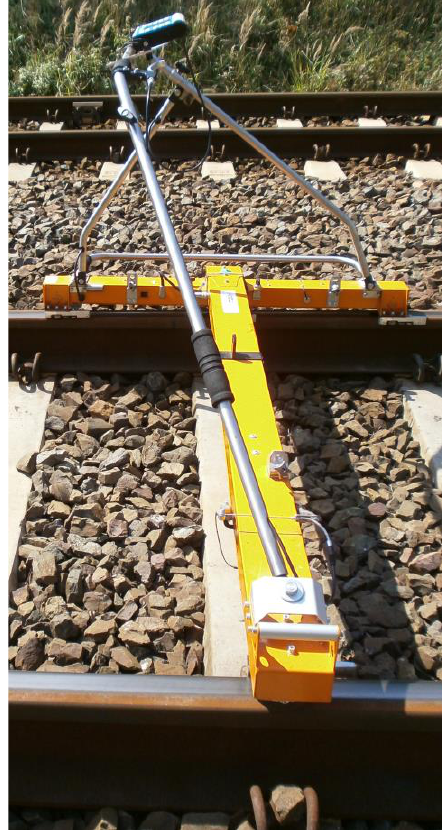
Figure 6. Electronic self-recording track gauge TEC-1435 N2.